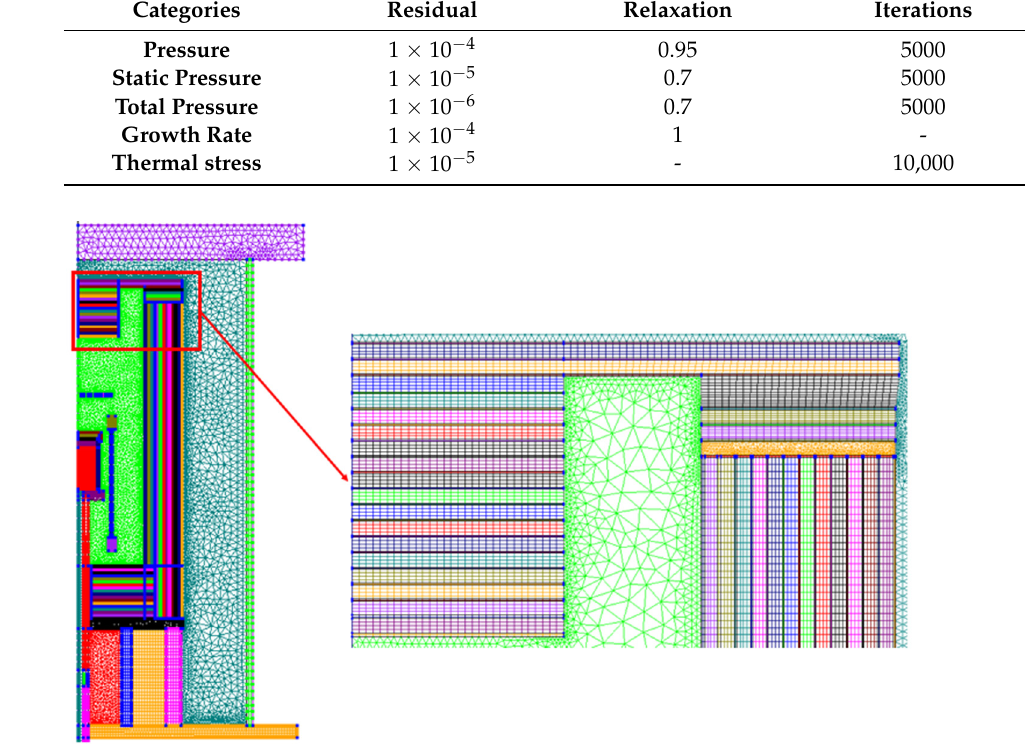
Figure 2. Adjusted model grid structure.